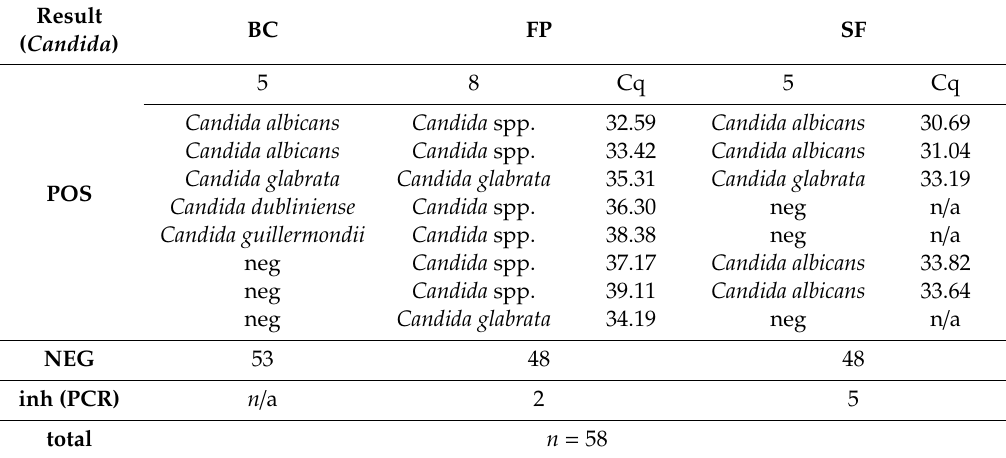
Table 2. Summary of test results comparing blood culture (BC) to the molecular detection by Fungiplex (FP) and SeptiFast (SF) PCR